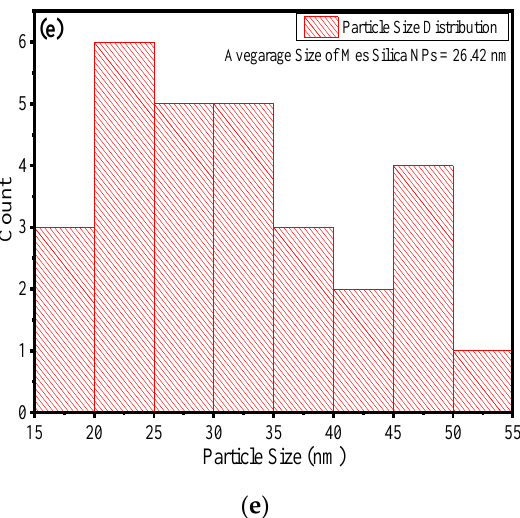
Figure 4. SEM image of ( a ) bare MSNs and ( b ) AS-g-PAni@MS nanocomposite. ( c ) EDX spectra showing individual constituent elements comprising the material. ( d ) TEM image of AS-g-PAni@MS nanocomposite showing the distribution of MSNs in the polymer matrix at 100 nm magnification range. ( e ) Gaussian distribution of particle size for assessing the average particle size of nanoparticles.